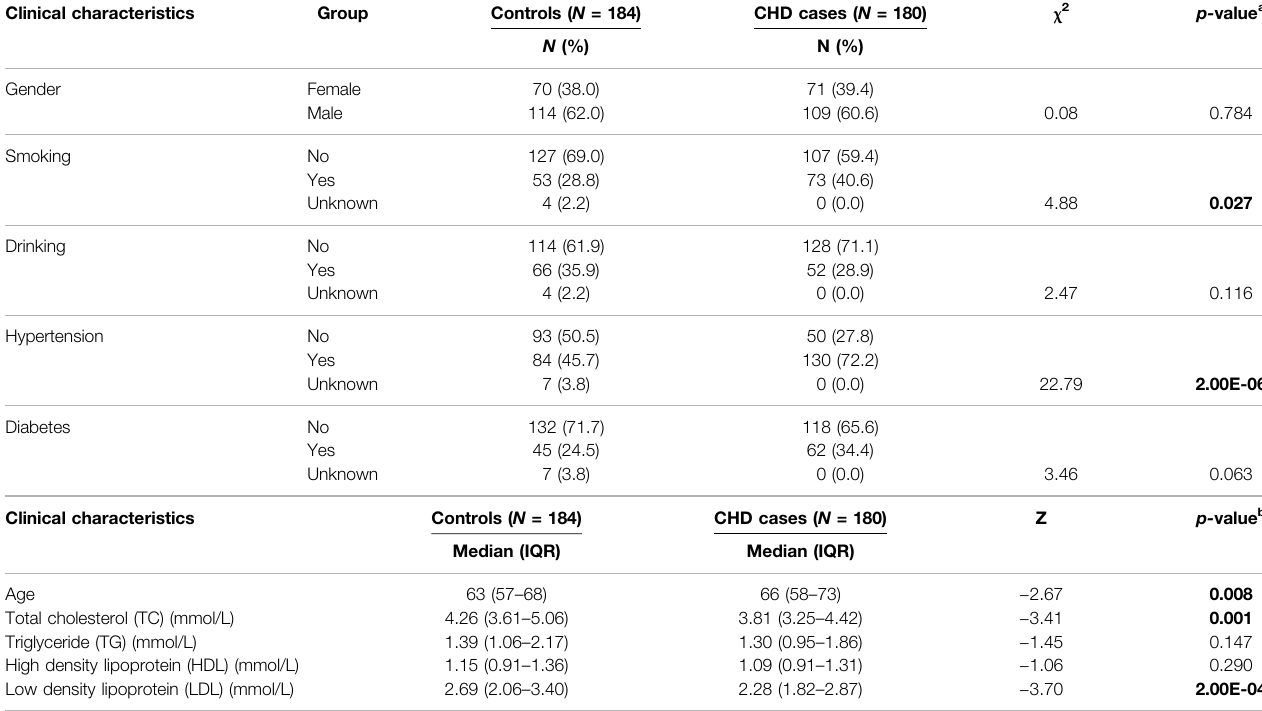
TABLE 1 | Baseline characteristics of coronary heart disease (CHD) patients and healthy controls. Clinical